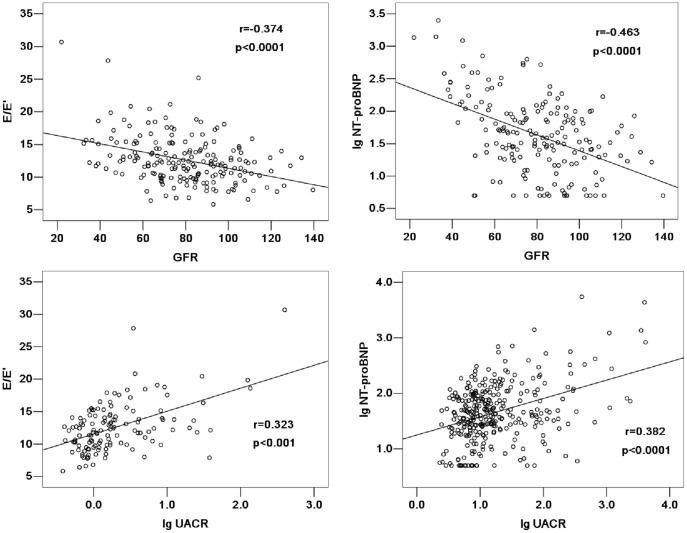
The relationship between GFR or UACR and E/E′ or NT-proBNP.GFR was significantly correlated with E/E′ and log-transformed plasma NT-proBNP, the correlation coefficient was −0.374 and −0.463 respectively (P<0.0001). Log-transformed UACR was also significantly correlated with E/E′ and log-transformed plasma NT-proBNP, the correlation coefficient was 0.323 and 0.382 respectively (P<0.0001).